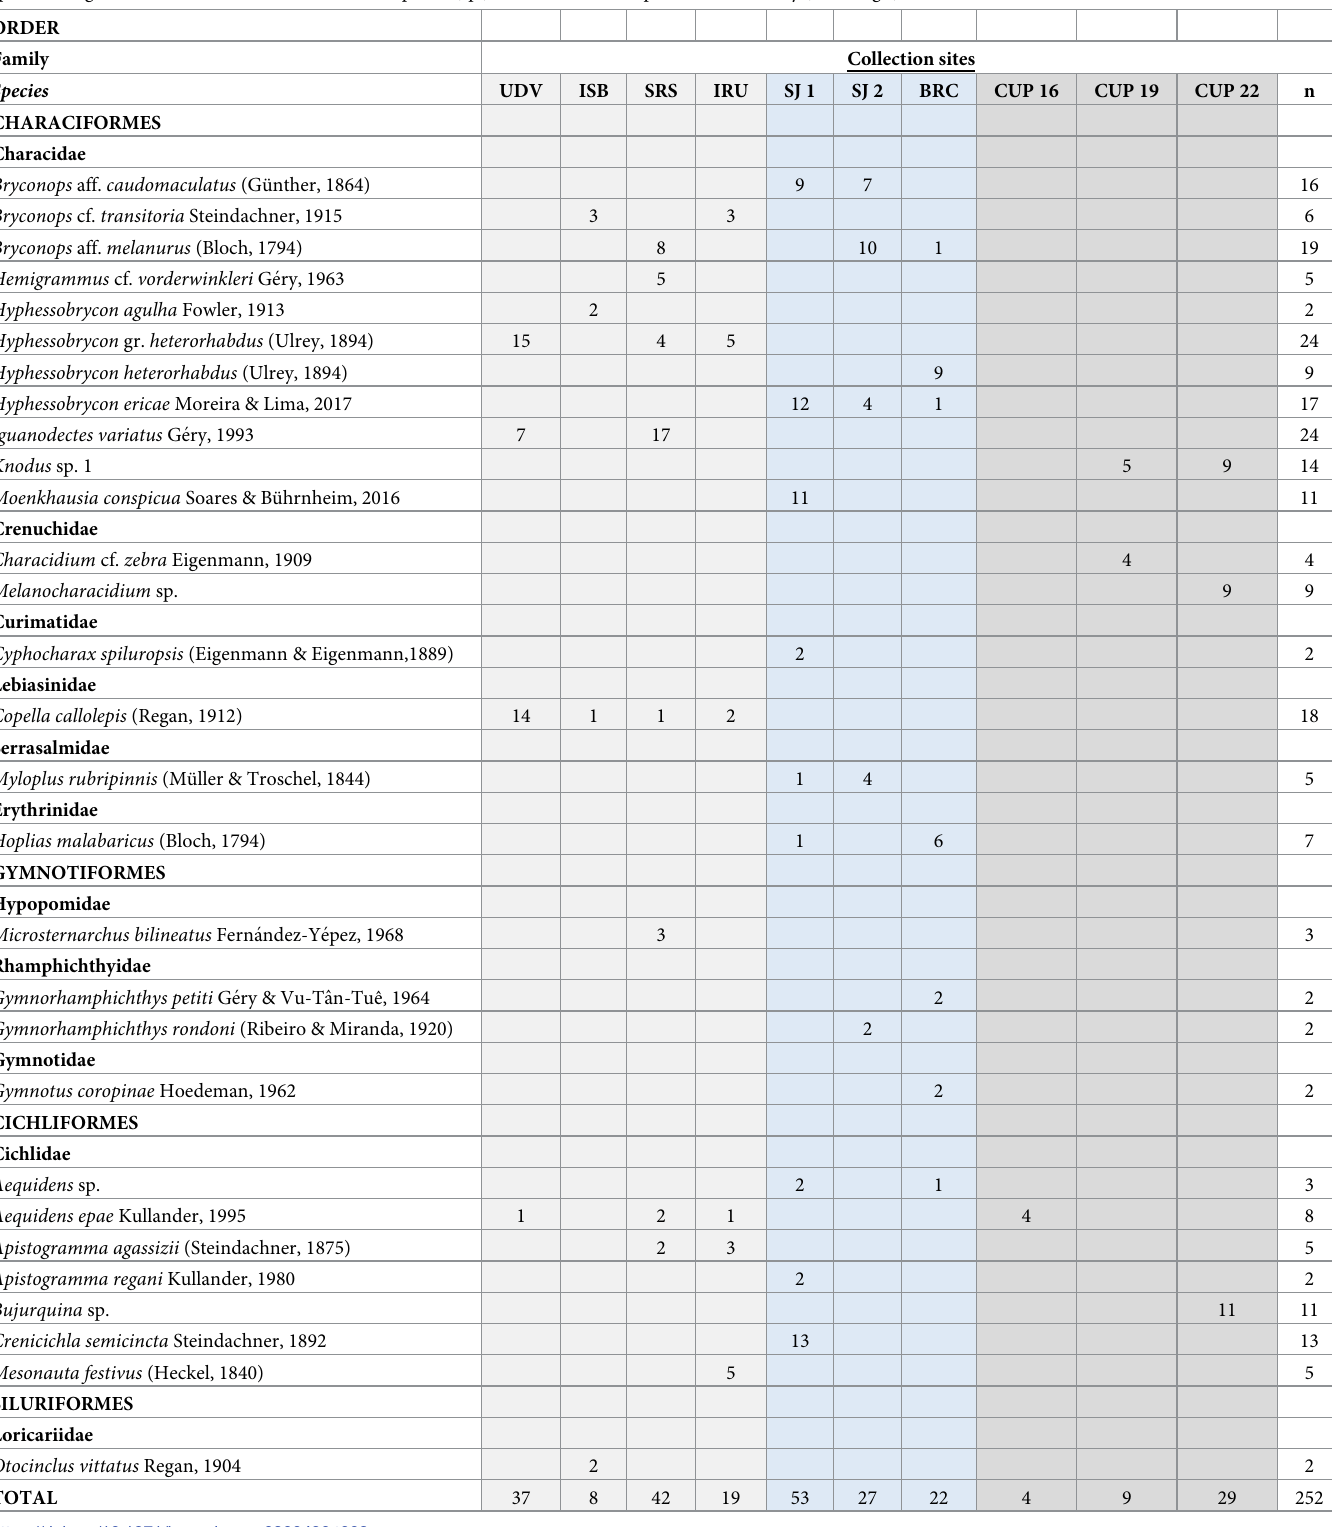
Table 2. Species list and barcoded specimens of fishes sampled in streams from the region of lower Tapajo´s River. Taxa (OTU) with uncertainties in morphological species recognition are listed either as undescribed species (sp.) or with uncertain species-level identity (aff., cf., gr.). ORDER